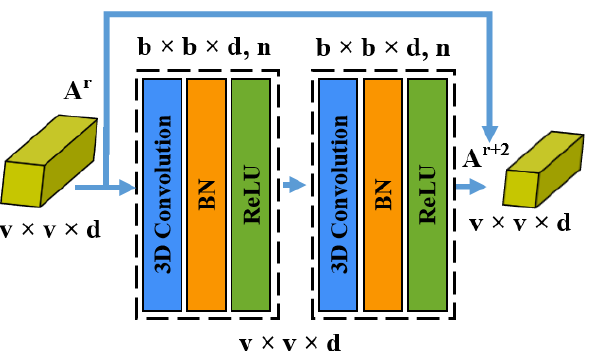
Figure 5. The spatial residual block consists of two successive 3D CNN layers, and a skip connection to add input feature maps A r directly to the output feature maps A r + 2